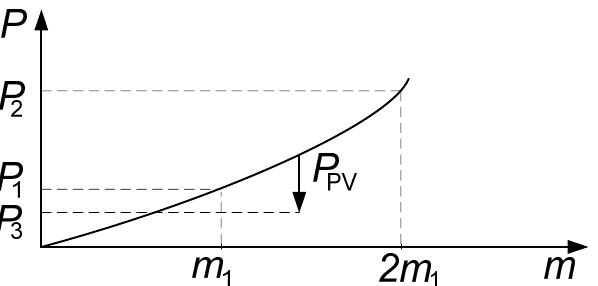
Figure 2. Simplified power diagram of energy relations for commercial fixed-wing radio-controlled aircraft of mass m 1 and for its modified version with a PV system with additional mass and power P PV. Power P 1 represents power from the battery for commercial aircraft, power P 2 represents the energy needed for propelling an aircraft with additional mass and power P 3 represents the modified aircraft with additional mass and an additional power source.